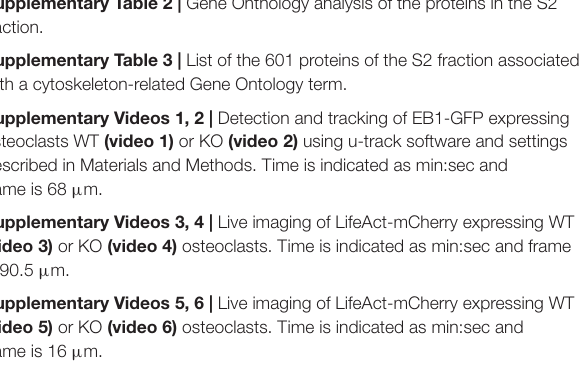
Supplementary Figure 1 | (A) Representative immunoblot showing TUBB6 and GAPDH expression in WT and Tubb6 KO RAW264.7 clones. Note in overexposed panel in the middle that clones 2 and 4 retain traces of TUBB6. (B) Bar graph showing the frequency of WT and KO osteoclasts seeded on glass and presenting podosome rings, normal or abnormal podosome belt, counting a total of 200 WT and KO osteoclasts in two independent experiments. (C) Bar graph showing the frequency of WT and KO osteoclasts seeded on ACC and presenting sealing zone and/or rings counting over 50 osteoclasts per clone. (D,E) Bar graphs showing the level of osteoclast characteristic Cathepsin K (D) and Src (E) mRNAs relative to Gapdh as determined by Q-PCR in WT or Tubb6 KO RAW264.7 cells (Pre-OC) or osteoclasts (OC). (F) Representative images showing TRAP staining in WT and Tubb6 KO osteoclasts. (G) Representative immunoblot blot showing intracellular content of alpha-tubulin, Cathepsin K proenzyme, and its mature form in total cell lysates of WT and Tubb6 KO osteoclasts, and the secretion of mature Cathepsin K in the culture medium of the same cells. (H) Representative immunoblot blot showing TUBB5, TUBB6 and GAPDH expression in primary bone marrow macrophages (Pre-OC) and osteoclasts (OC) and in WT or Tubb6 KO RAW264.7 cells (pre-OC) or osteoclasts (OC). Supplementary Figure 2 | Bar graph showing mean and SEM α -tubulin aster area after nocodazole washout in osteoclasts transfected with luciferase control siRNA or Tubb6 siRNAs si1077 and si1373, measuring at least 20 asters per group were measured in four independent experiments. Supplementary Figure 3 | (A) Table showing the details of microtubule dynamics parameters from u-track analysis (B) Minimum to maximum boxplot showing microtubule growth speed determined in ImageJ 1.53c with MTrackJ in 15 WT and Tubb6 KO osteoclasts expressing EB1-GFP from three independent experiments and measuring 10–11 comets per osteoclasts; Mann–Whitney test: ∗∗∗ p < 0.0002. (C,D) Representative EB1-GFP comets tracks in WT (C) and Tubb6 KO (D) analyzed in (B) . (E) Minimum to maximum boxplot showing the length of the EB1-GFP signal in 18 WT and Tubb6 KO osteoclasts per condition from three independent experiments and measuring 25 comets in each osteoclast to determine the average comet length per osteoclast; Mann–Whitney test: ∗∗∗∗ p < 0.0001. (F,G) Representative images of the EB1-GFP signal at the tip of microtubules in WT (F) and KO (G) osteoclasts analyzed in (E) . Supplementary Figure 4 | (A) Representative live confocal images of osteoclasts derived from WT or Tubb6 KO osteoclasts expressing LifeAct-mCherry and sitting on glass, showing the localization of LifeAct-mCherry signal at t0 = 0 min (red) and t2 = 6.5 min (green), with the overlapping areas in yellow. (B) Minimum to maximum boxplot showing the percentage of LifeAct-mCherry signal at t0 that persists at the same position at t2 in WT or Tubb6 KO osteoclasts; in a total of 22 WT and 21 KO osteoclasts from four different experiments. Mann–Whitney test: ∗∗ p < 0.01. Supplementary Table 1 | Proteomic data from Max Quant treated with Perseus. Supplementary Table 2 | Gene Onthology analysis of the proteins in the S2 fraction. Supplementary Table 3 | List of the 601 proteins of the S2 fraction associated with a cytoskeleton-related Gene Ontology term. Supplementary Videos 1, 2 | Detection and tracking of EB1-GFP expressing osteoclasts WT (video 1) or KO (video 2) using u-track software and settings described in Materials and Methods. Time is indicated as min:sec and frame is 68 µ